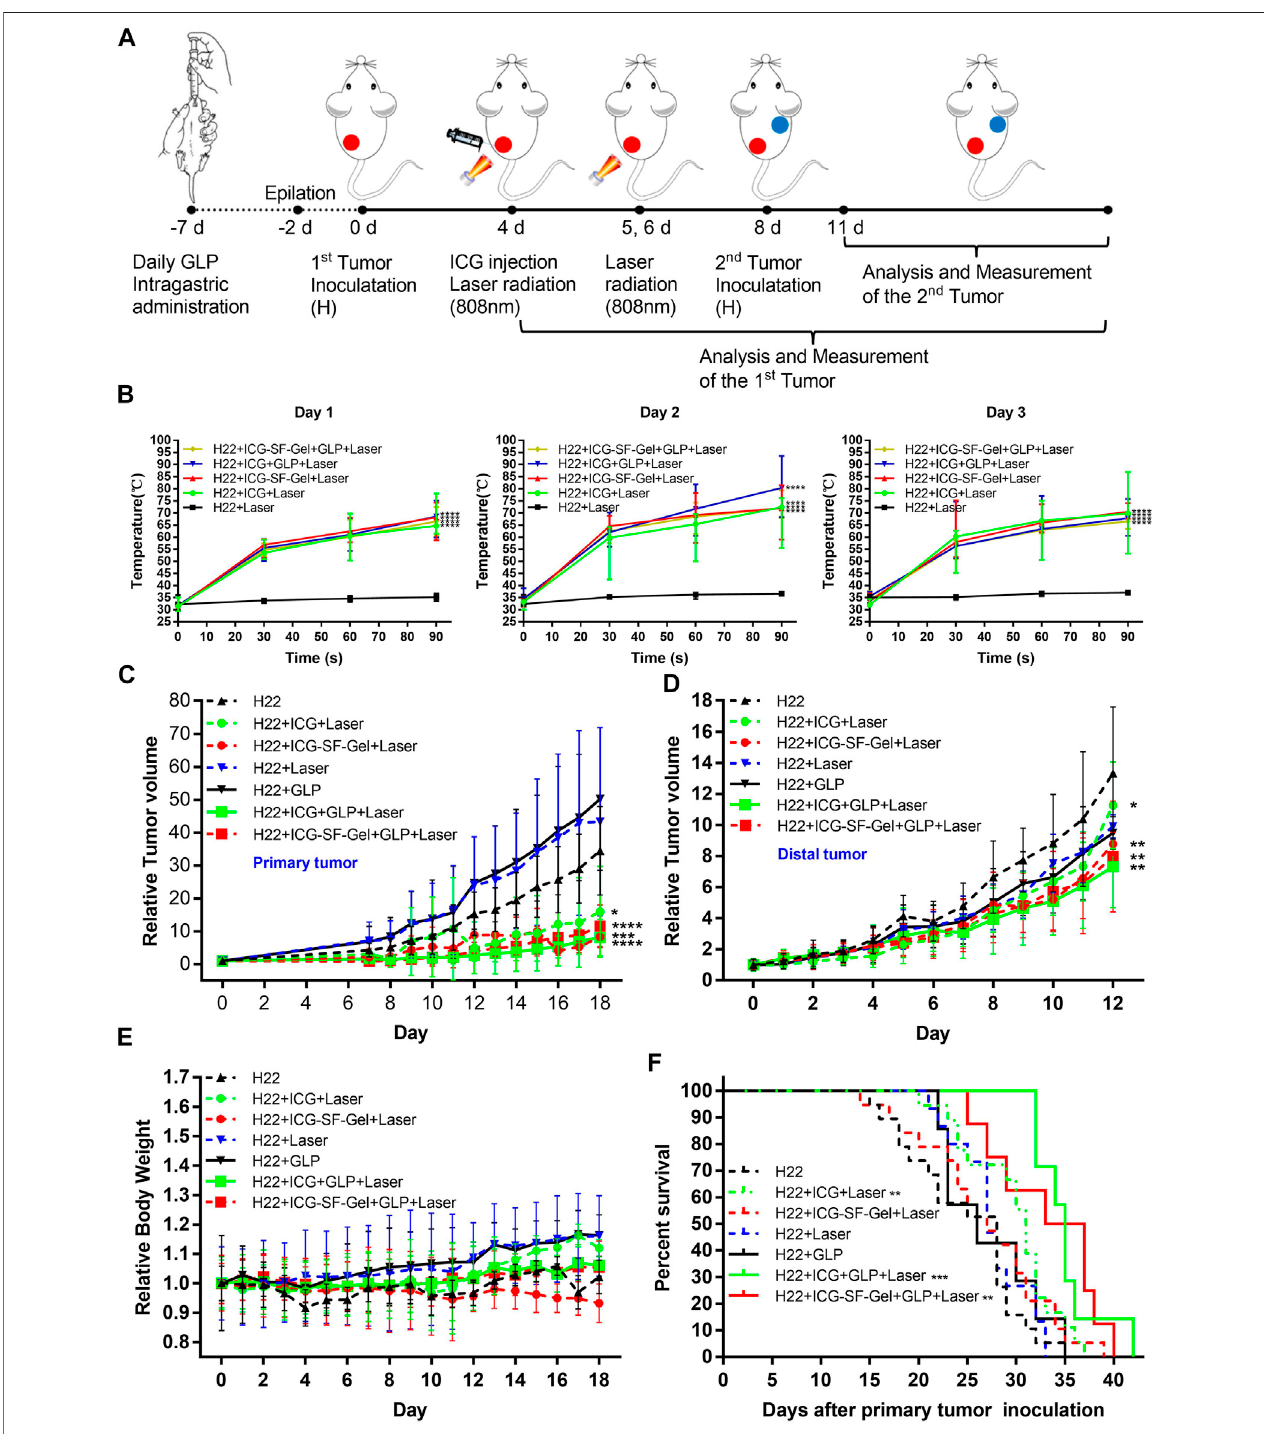
FIGURE 4 | Inhibition of the tumor growth in vivo . (A) Schematic illustration of ICG/ICG-SF-Gel-based photothermal therapy and GLP immunotherapy to inhibit distal tumor growth; (B) The temperature changes of tumor area in fi ve groups mice after NIR irradiation during the 3 days NIR irradiation ( n (cid:2) 6 – 9 mice per group, data are presented as the mean ± SD. Statistical signi fi cance was expressed by * p < 0.05, ** p < 0.01, *** p < 0.001 and **** p < 0.0001, comparing other groups with the H22 group); (C – E) Therelativetumorvolumeofprimarytumors (C) ordistaltumors (D) andtherelativebodyweight (E) insevengroupsmiceafterdifferenttreatmentsto their primary tumors ( n (cid:2) 10 – 15 mice per group, data are presented as the mean ± SD. Statistical signi fi cance was expressed by * p < 0.05, ** p < 0.01, *** p < 0.001 and **** p < 0.0001,comparingothergroupswiththeH22group); (F) Thesurvivalcurveofsevengroupsmiceafterprimarytumorinoculation.Survivalcurveswerecompared betweengroups using thelog-rank test ( n (cid:2) 7 – 19mice per group, dataare presented asthemean ± SD.Statistical signi fi cance wasexpressed by* p < 0.05, ** p < 0.01, *** p < 0.001 and **** p < 0.0001, comparing other groups with the H22 group).